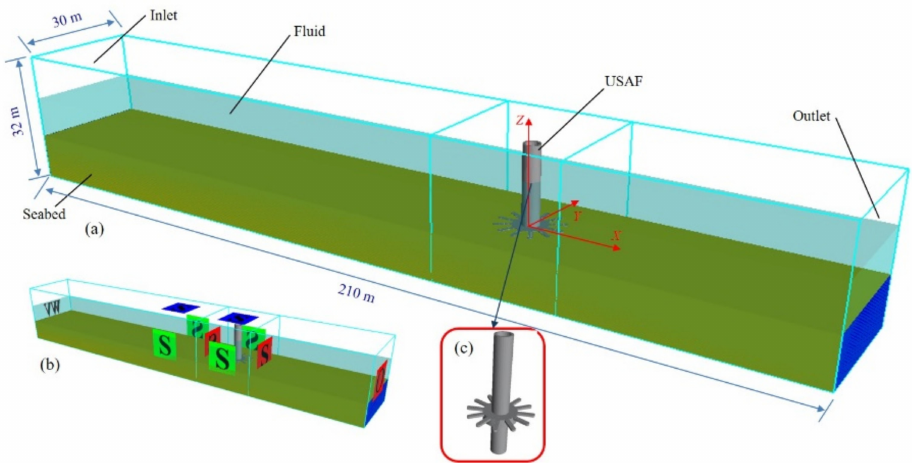
Figure 2. ( a ) The sketch of seabed-USAF-wave three-dimensional model; ( b ) boundary condation:Wv- wave boundary, S-symmetric boundary, O-outflow boundary; ( c ) USAF model. Table 1. Numerical simulating cases.